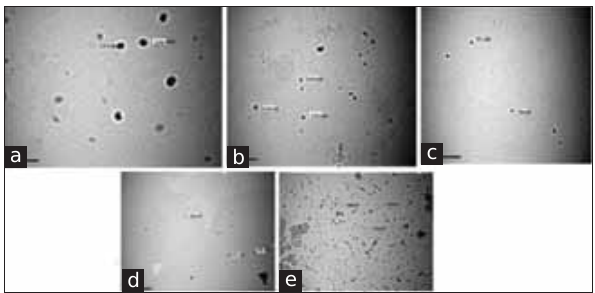
Figure-2: (a) Transmission electron microscopy (TEM) images of gold nanoparticle (GNP) (using 0.09375% sodium citrate), (b) TEM images of GNP (using 0.1875% sodium citrate), (c) TEM images of GNP (using 0.375% sodium citrate), (d) TEM images of GNP (using 0.75% sodium citrate), (e) TEM images of GNP (using 1.5% sodium citrate).